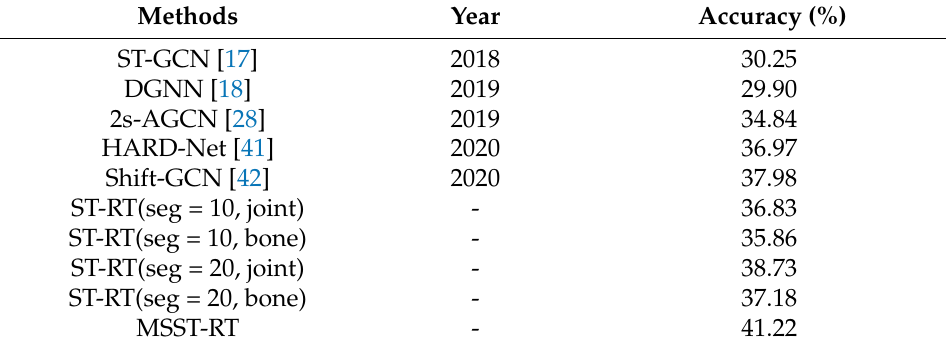
Table 3. Performance comparison on